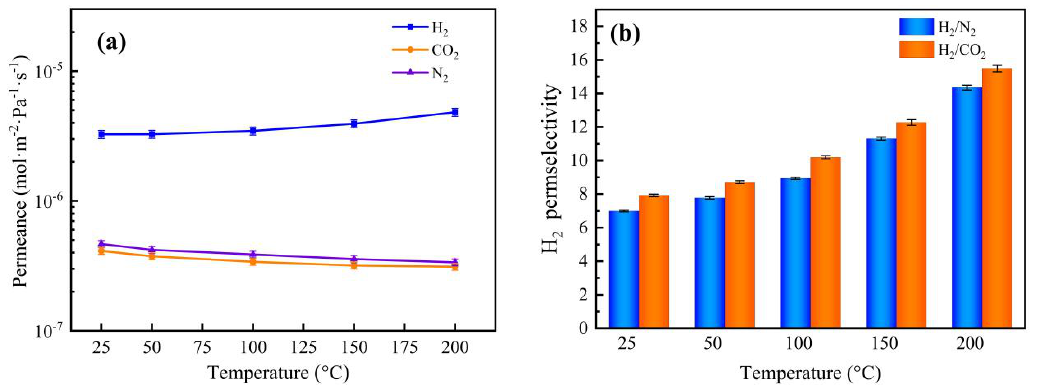
Figure 15. Effect of temperature on ( a ) gas permeance and ( b ) H 2 permselectivity of Nb/SiO 2 membrane with n Nb = 0.08 at a pressure difference of 0.1 MPa.